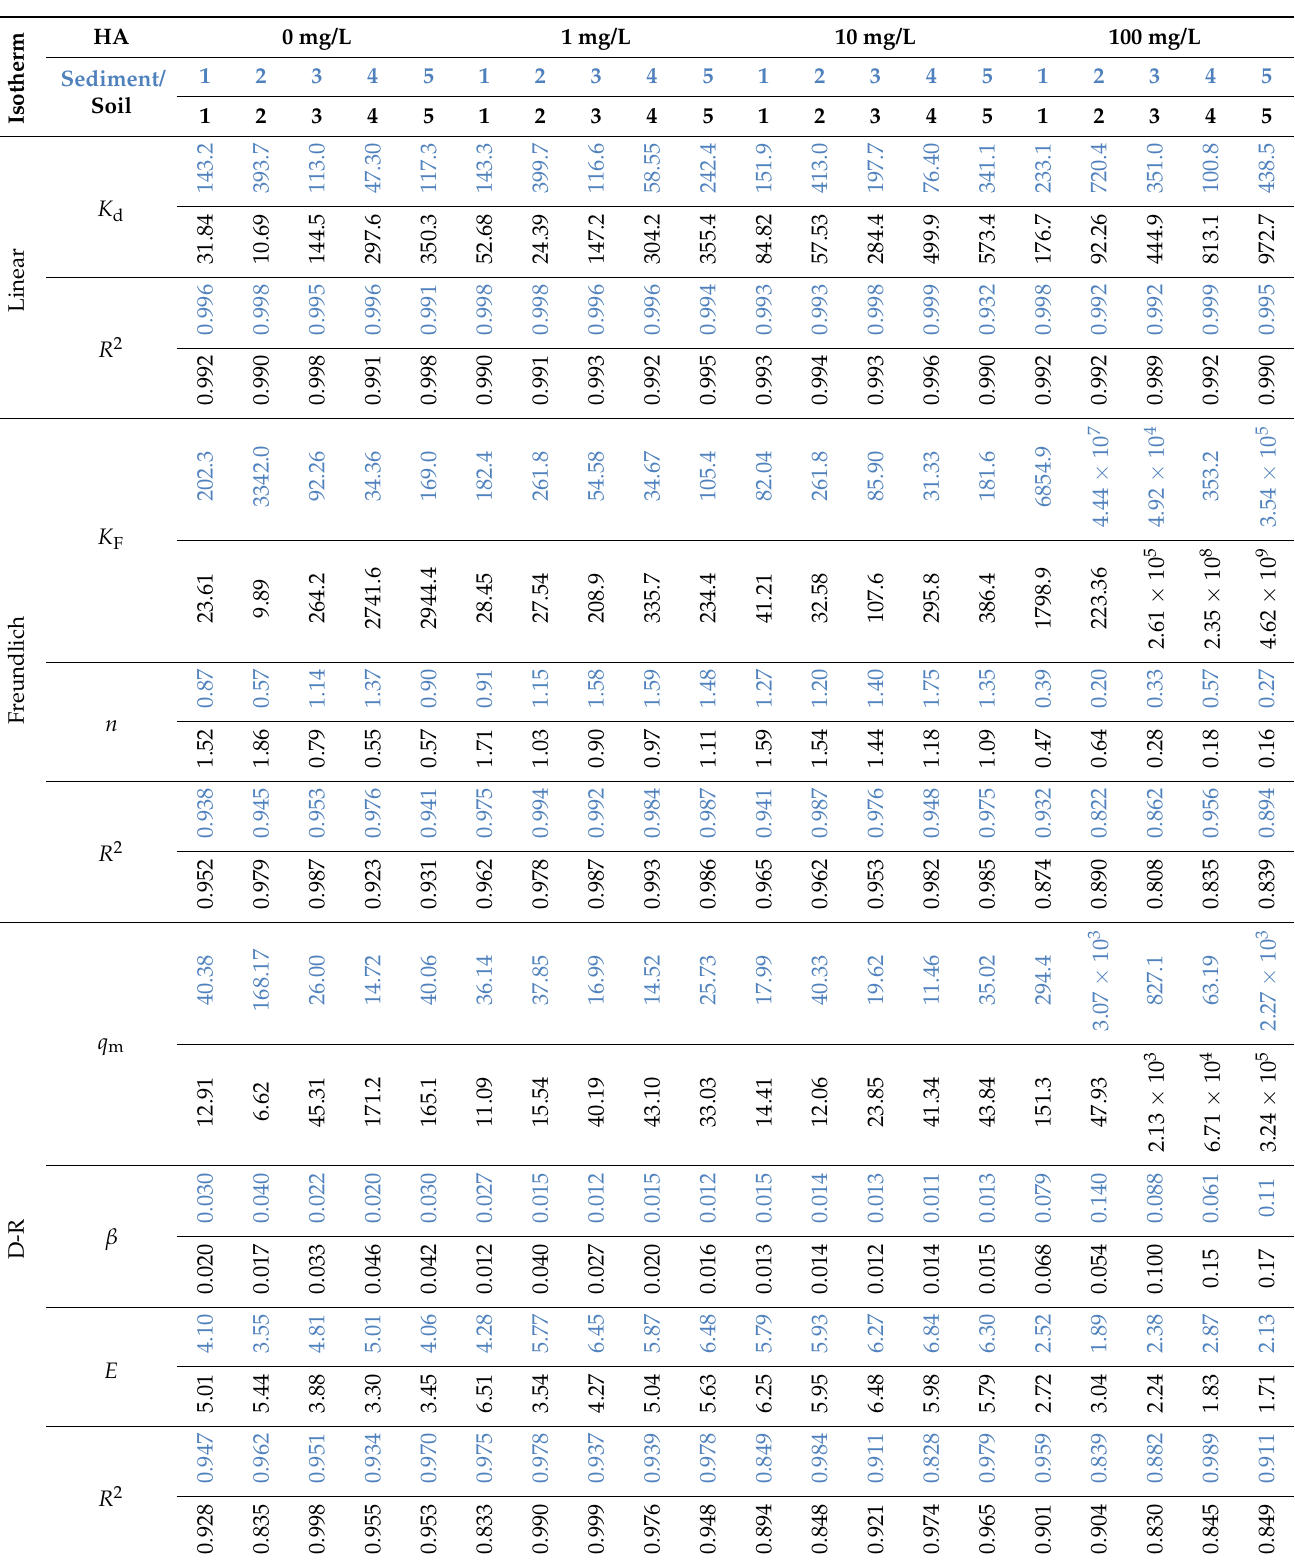
Table 1. The linear, Freundlich, and Dubinin–Radushkevich isotherm parameters for